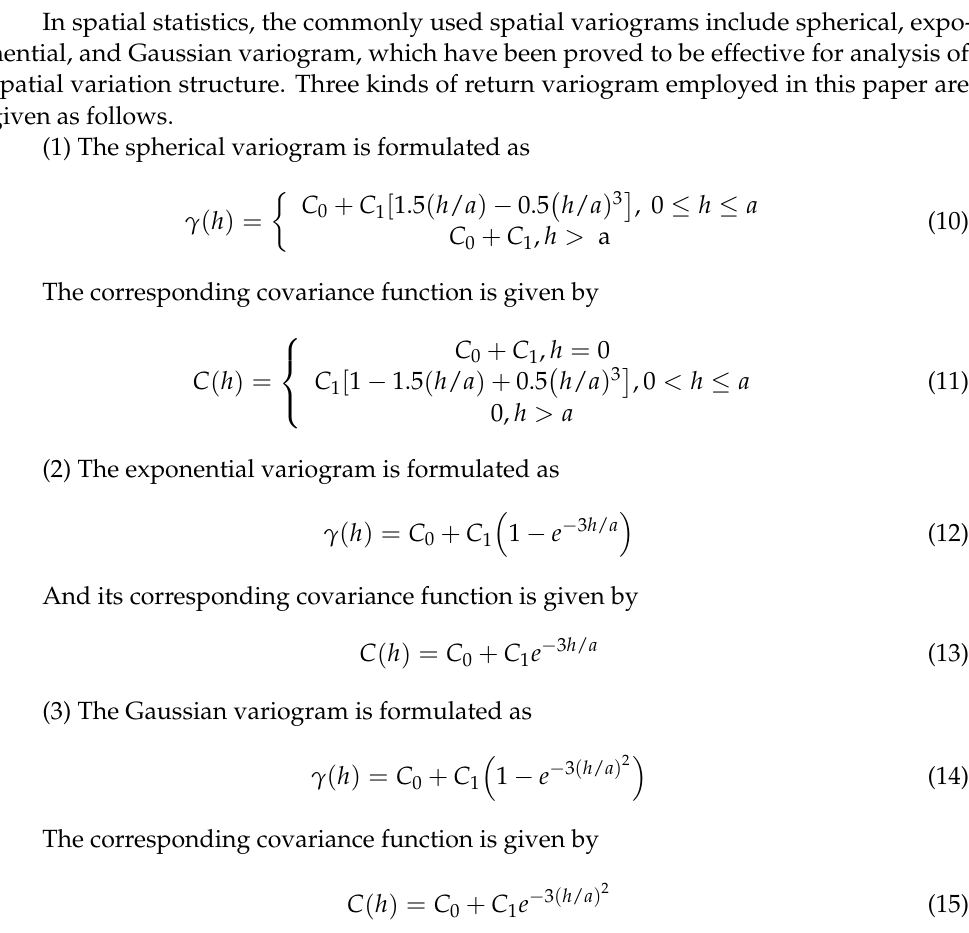
Figure 3. Spatial variogram of WEEE return amount.